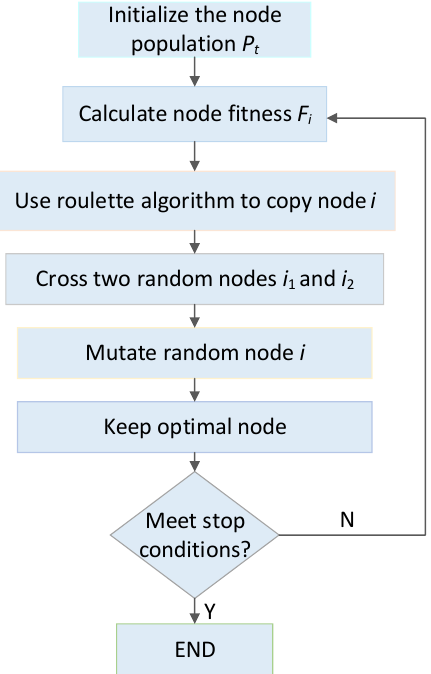
Figure 4. Process of applying the genetic algorithm in cloud storage strategy.